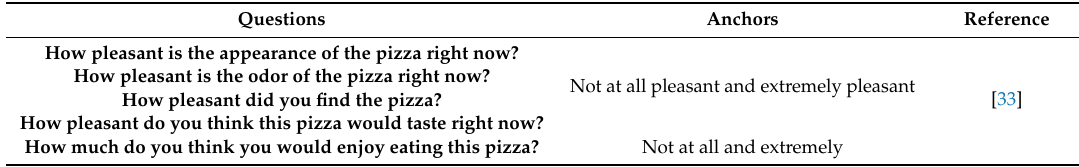
Table 2. Food pleasantness visual analog